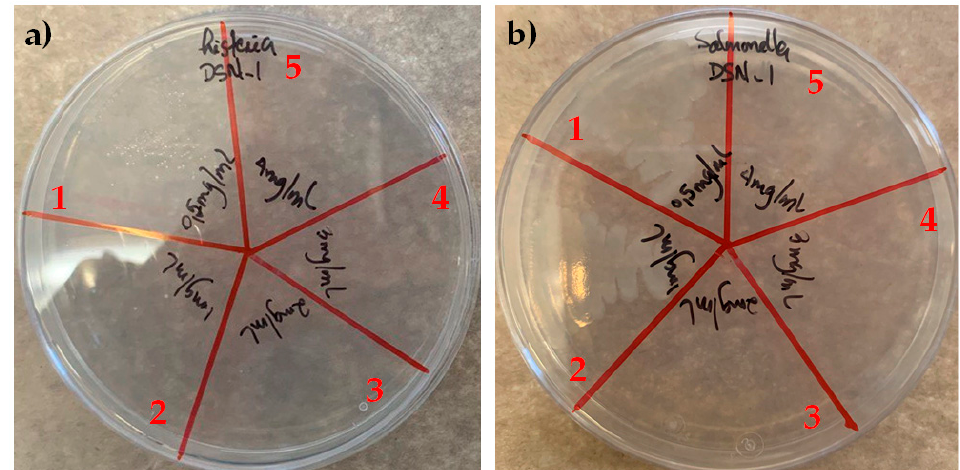
Figure 2. MBC of CuHS against ( a ) L. monocytogenes ; ( b ) S. enterica . The numbers correspond to the following concentrations: 1 corresponds to 0.5 mg/mL; 2 to 1 mg/mL; 3 to 2 mg/mL; 4 to 3 mg/mL; and 5 to 4 mg/mL.